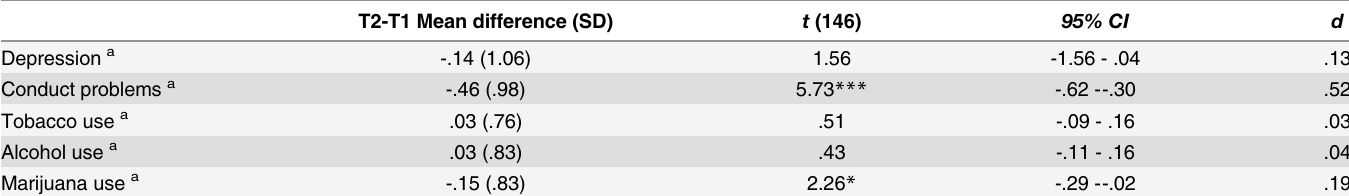
Table 2. Change in symptom severity and frequency or substance use between T1 and T2 within the childbearing group (N =